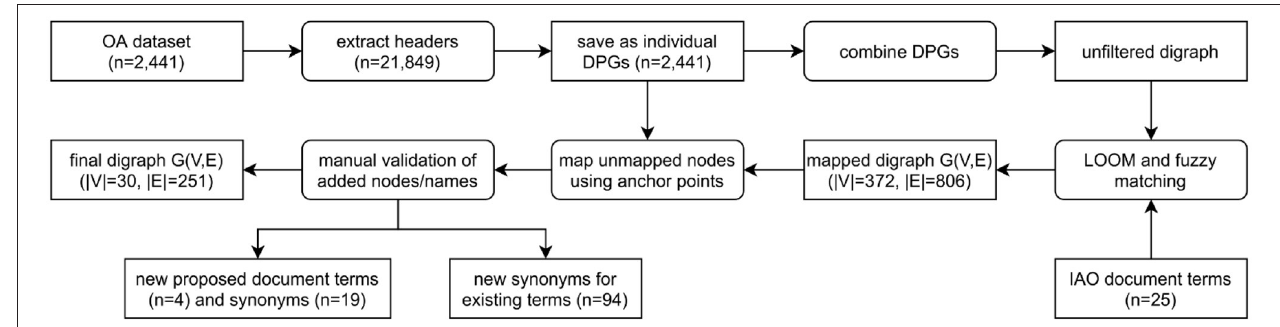
FIGURE 3 | Flow diagram demonstrating the process of classifying publication sections with IAO terms. The unfiltered digraph is visualized in Supplementary Figure 1 , and the process of combining DPGs and mapping unmapped nodes using anchor points in Supplementary Figure 2 . DPG, directed path graph; G(V,E), graph(vertex, edge); IAO, information artifact